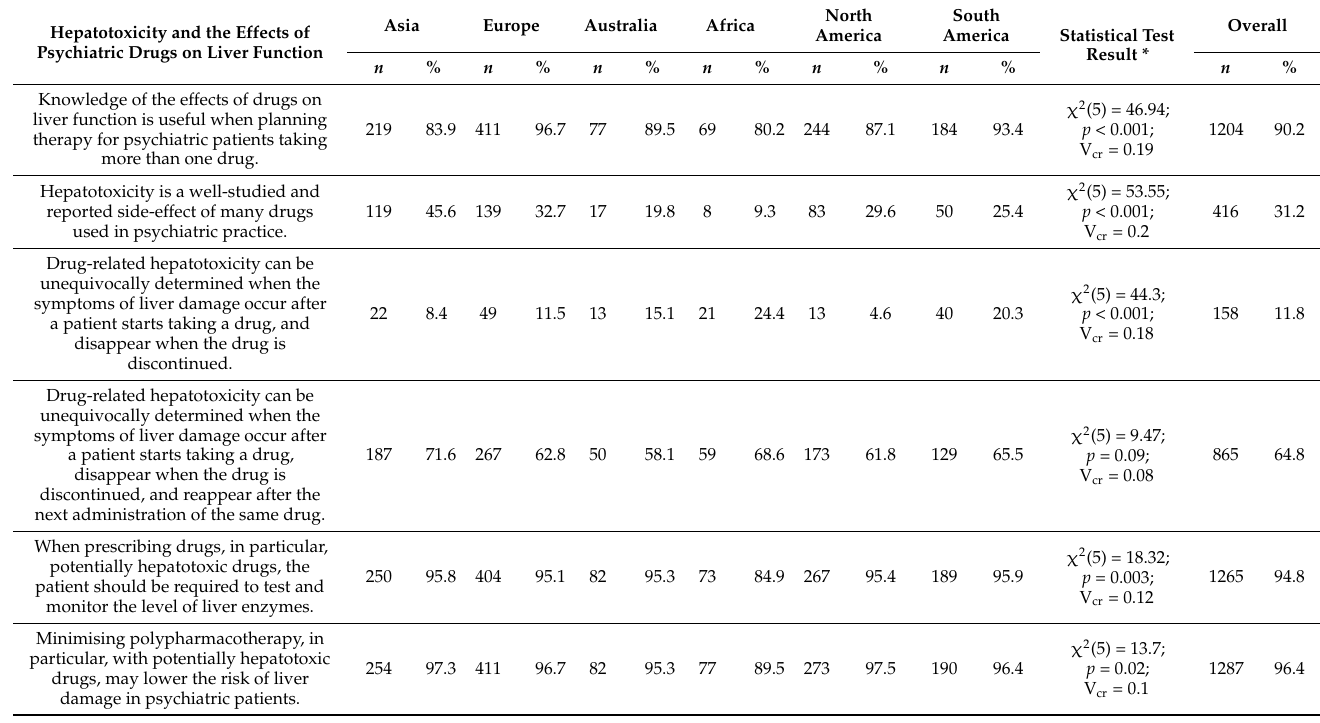
Table 7. Psychiatrists’ answers on the hepatotoxicity and the effects of psychiatric drugs on liver